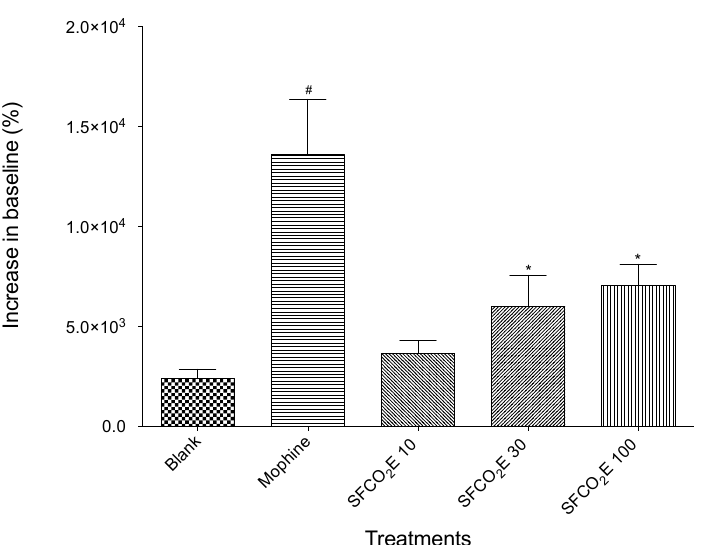
Figure 6. The results from the hot plate model of treated mice (SFCO 2 E at 10, 30, and 100 mg / kg) were compared with mice that were given vehicle (blank) and morphine (2.5 mg / kg) used as positive control. This figure shows the increase of the baseline against the untreated mice (blank). The treatments which show a significant increase in the baseline size compared to blank are marked with (*), p < 0.05. (#), p < 0.01.